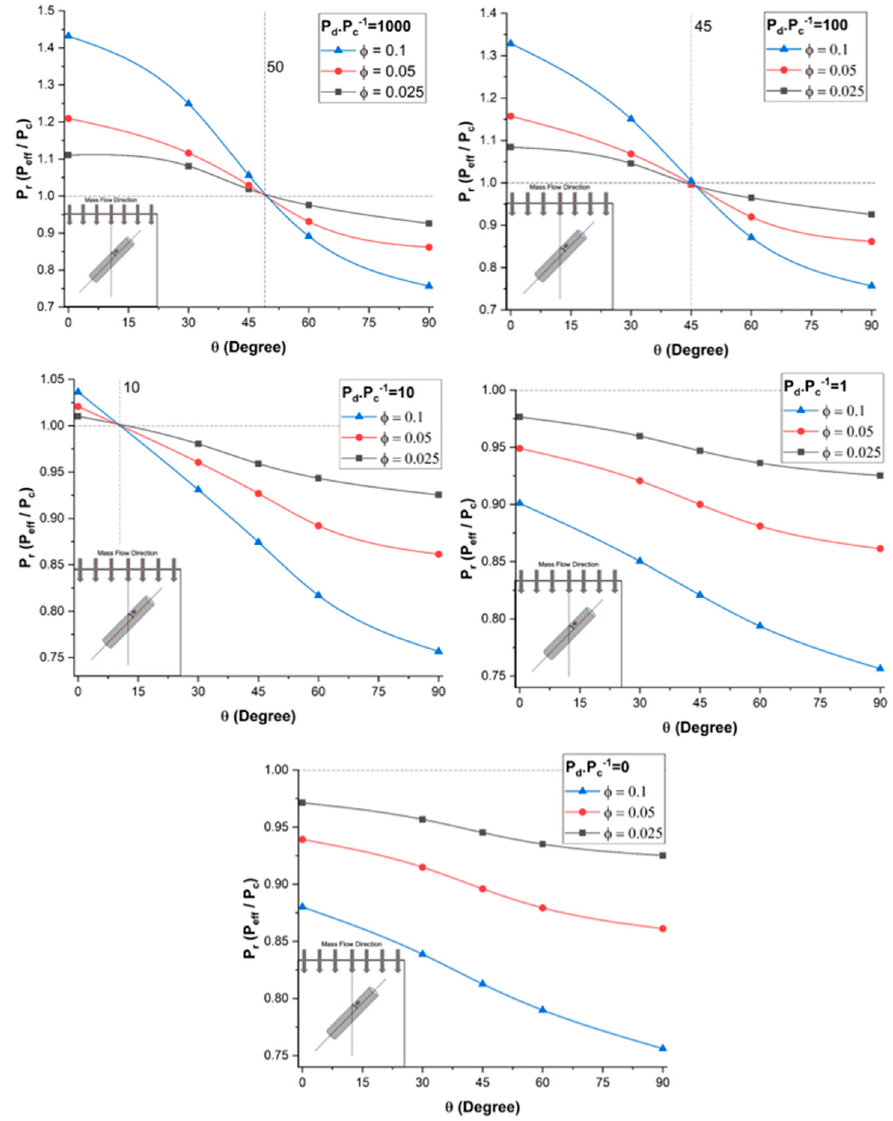
Figure 6. Plots of the relative permeability of mixed-matrix membranes incorporating nanotubes as a function of the nanotube orientation for five different P d / P c ratios, three filler volume fractions, and at a constant length-to-diameter aspect ratio α = 10.